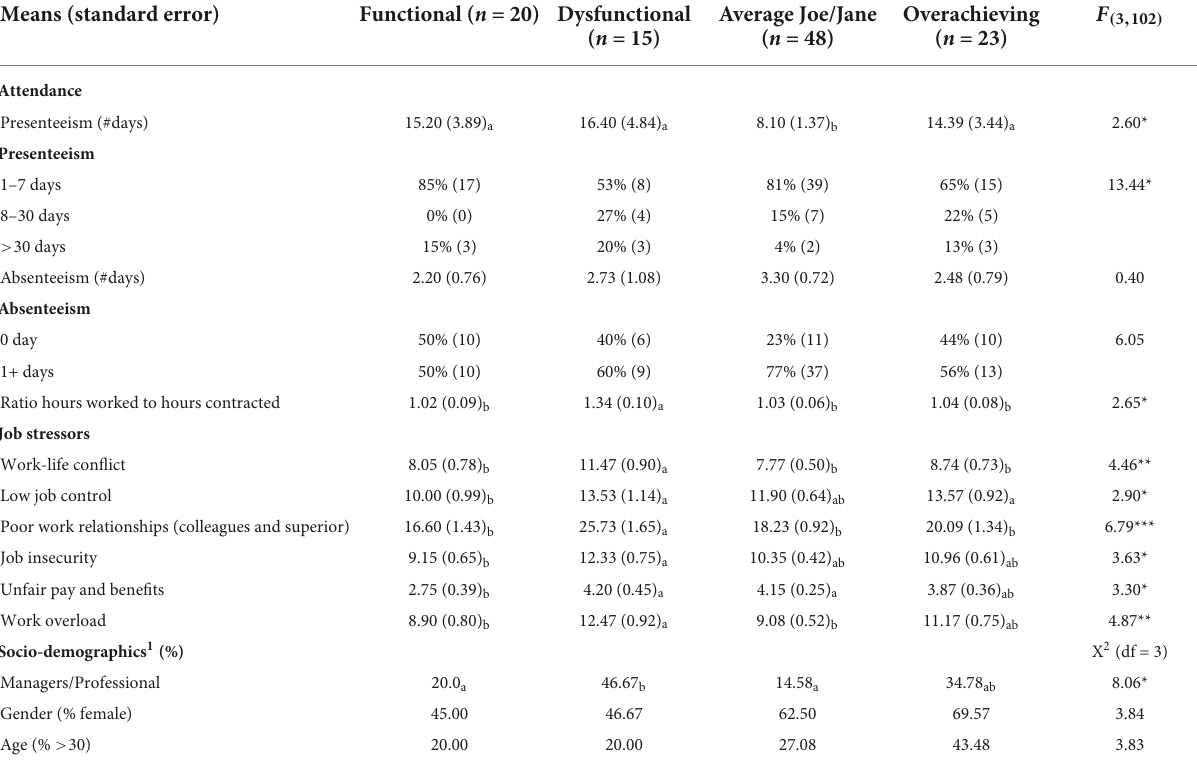
TABLE 3 Analysis of attendance, job stressors, attitudinal, and socio-demographic characteristics for the four profiles. Means (standard